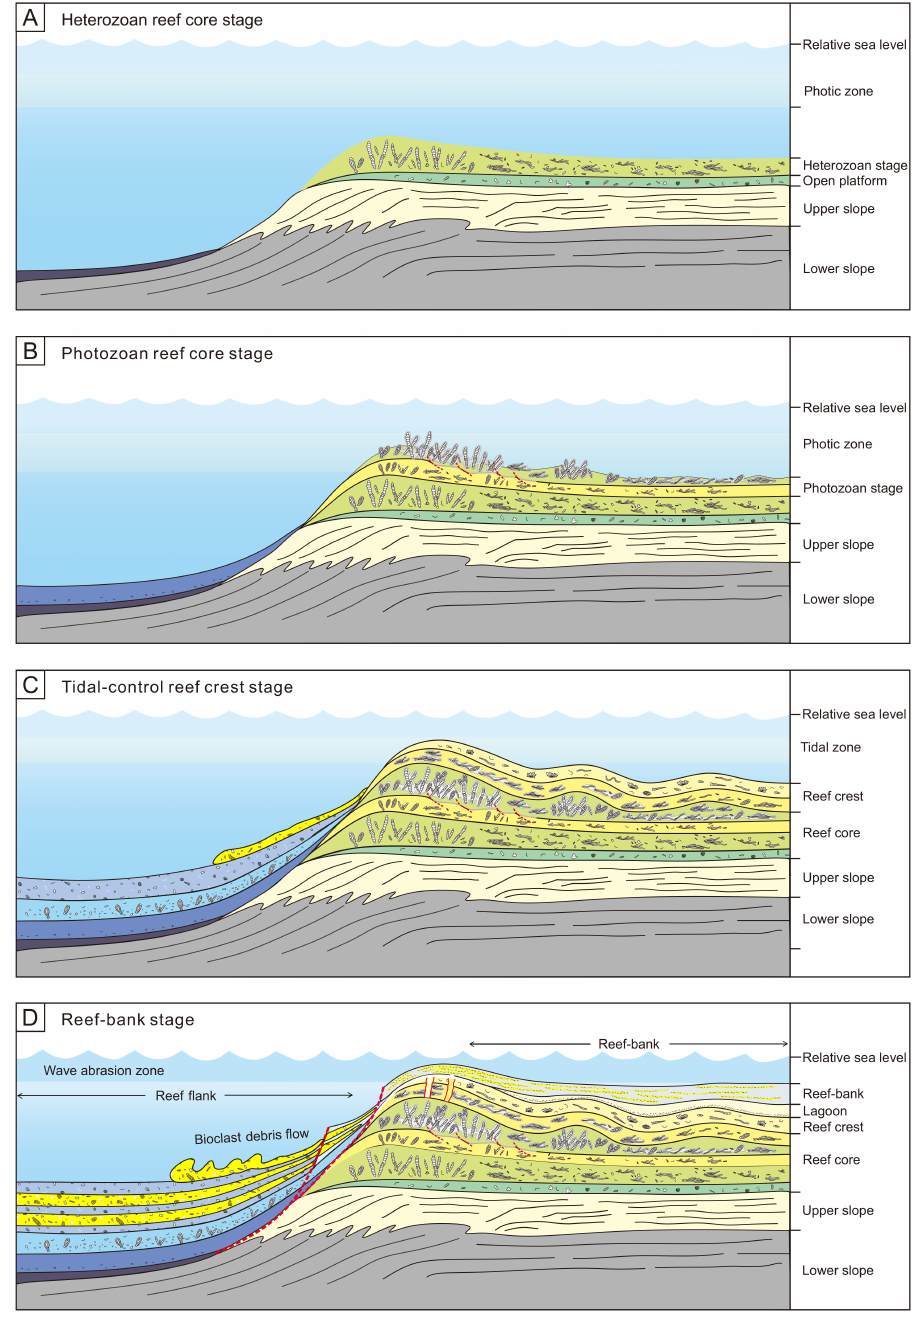
Figure 12. Dynamic development model of the Jiantianba reef complex. The development of Jiantianba reef consists of four phases: ( A ) the heterozoan reef core stage: reef developed in the marginal platform within muddy surroundings; ( B ) the photozoan reef core stage: reef developed within the photic zone, and water is warm and the illumination is adequate; ( C ) the tide-controlled reef crest stage: reef crest developed in the very shallow depth and controlled by the tide action; ( D ) the reef-bank stage: sedimentation process is dominated by wave abrasion and bioclastics contents extremely